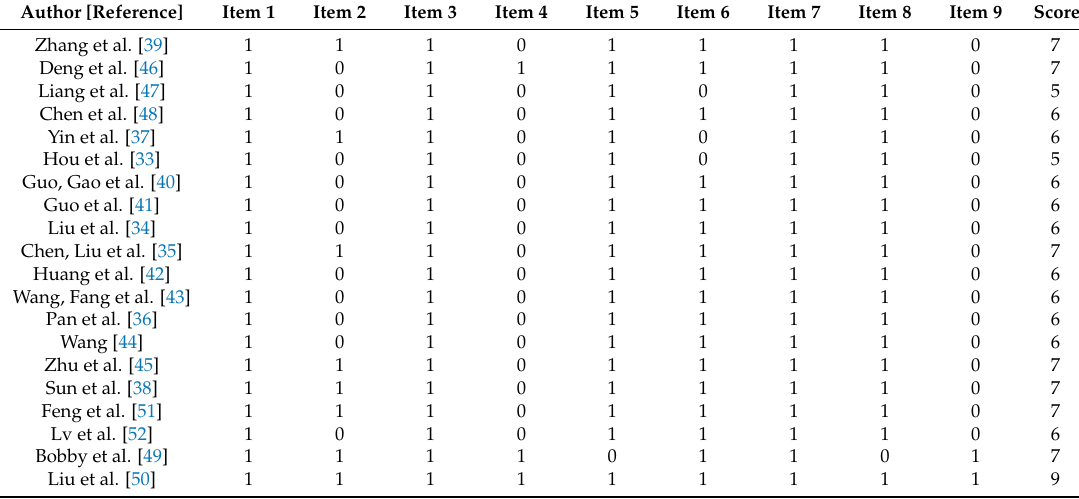
Table 2. Study quality assessment for eligible randomized controlled